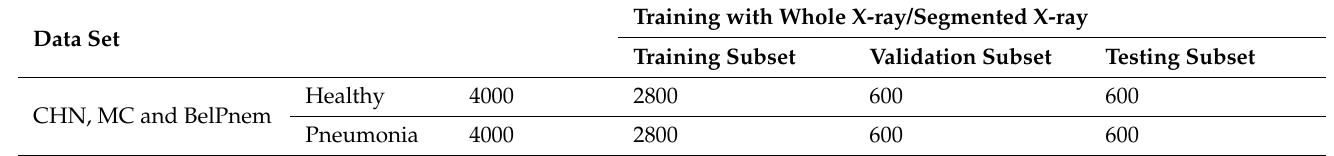
Table 4. Training, validation and test subsets for the deep learning model.